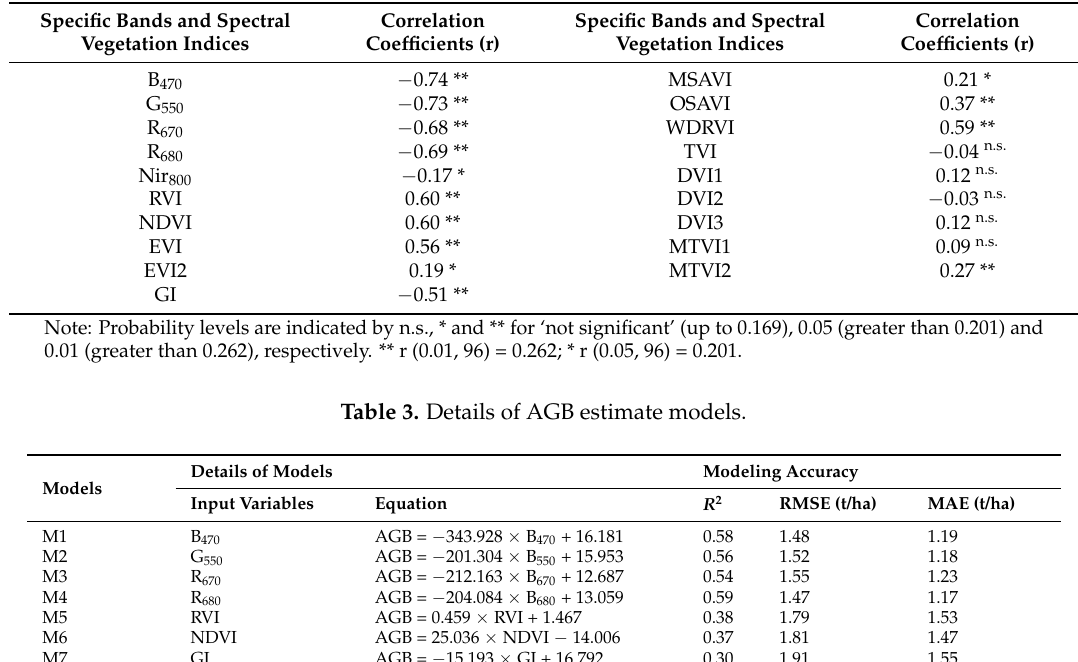
Table 2. Correlation coefficients (r) between AGB, specific bands and spectral vegetation indices (n = 96).